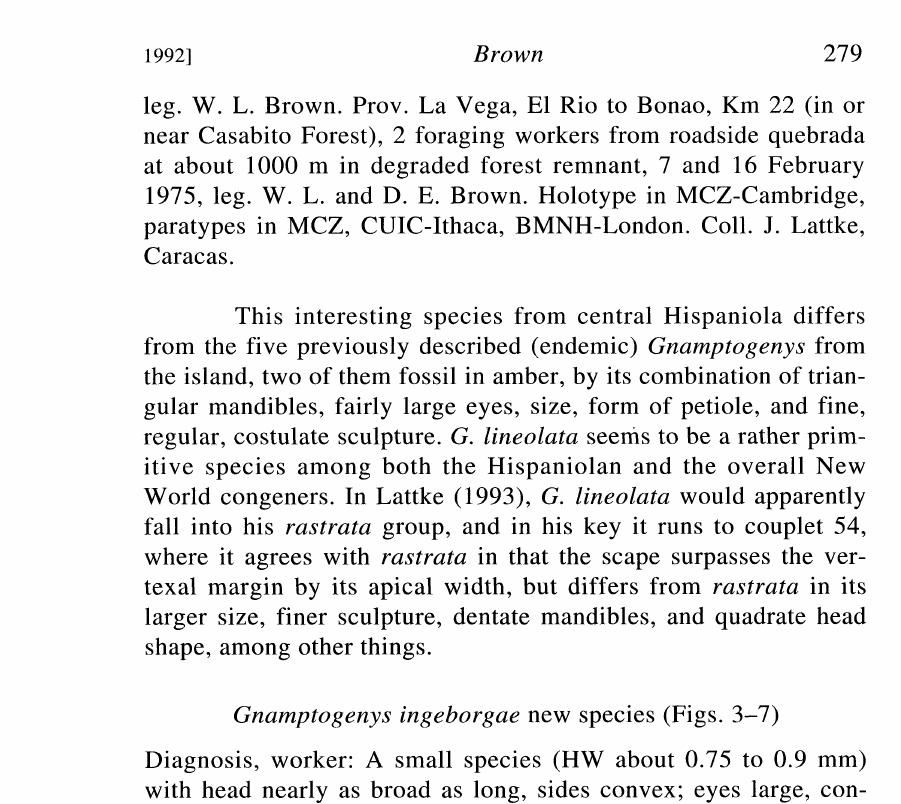
togenys ingeborgae new species. Fig. 5, Stinging position of the ant on the milli- pede, with the millipede already dead or paralyzed. Fig. 6, Ant begins to bite at ventral postcephalic area of outstretched millipede while pressing its undercurled gastric apex against the millipede’s postcephalic dorsum in preparation for wrench- ing off its head region; action takes place in or just outside ant’s nest cell. Fig. 7, Feeding of small ant larvae on millipede carcass on floor of nest cell. Drawings by David